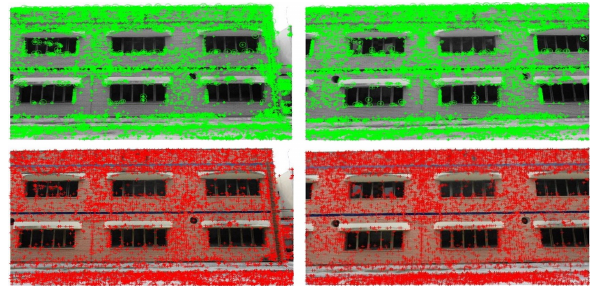
Figure 3. Keypoints detected by SURF (green) and SIFT (red) operators in 2 nd dataset